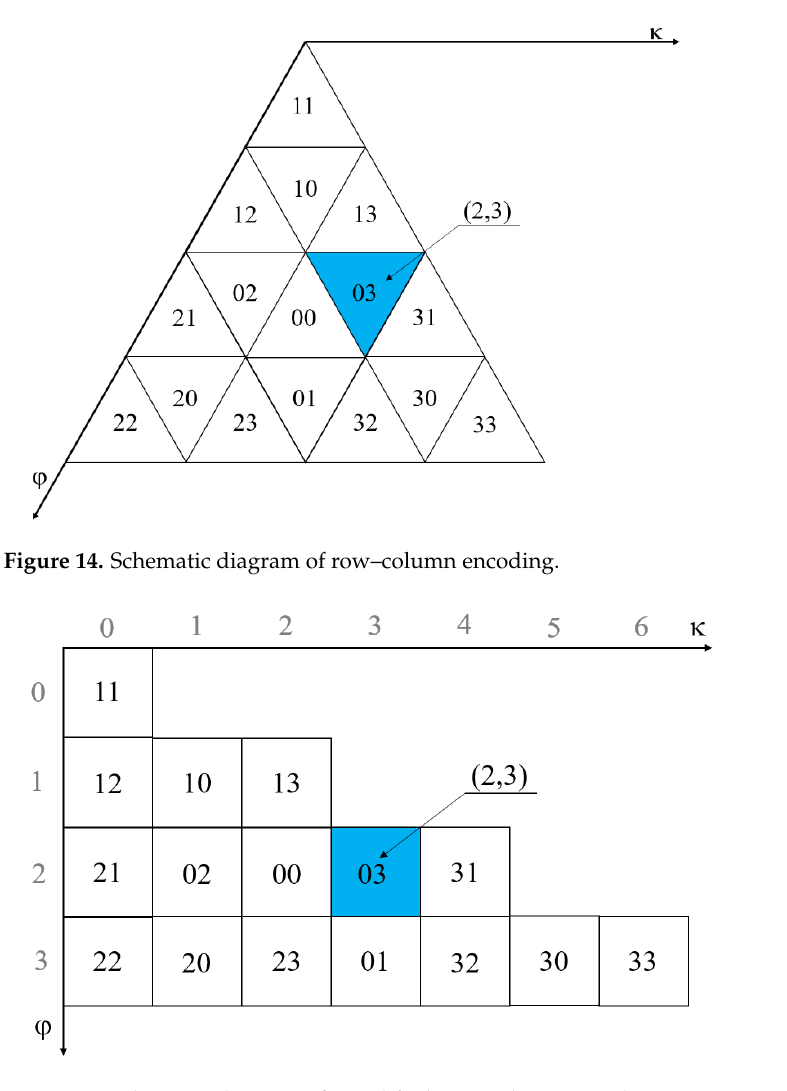
Figure 15. Schematic diagram of simplified row–column encoding. (1) Row and column algorithm